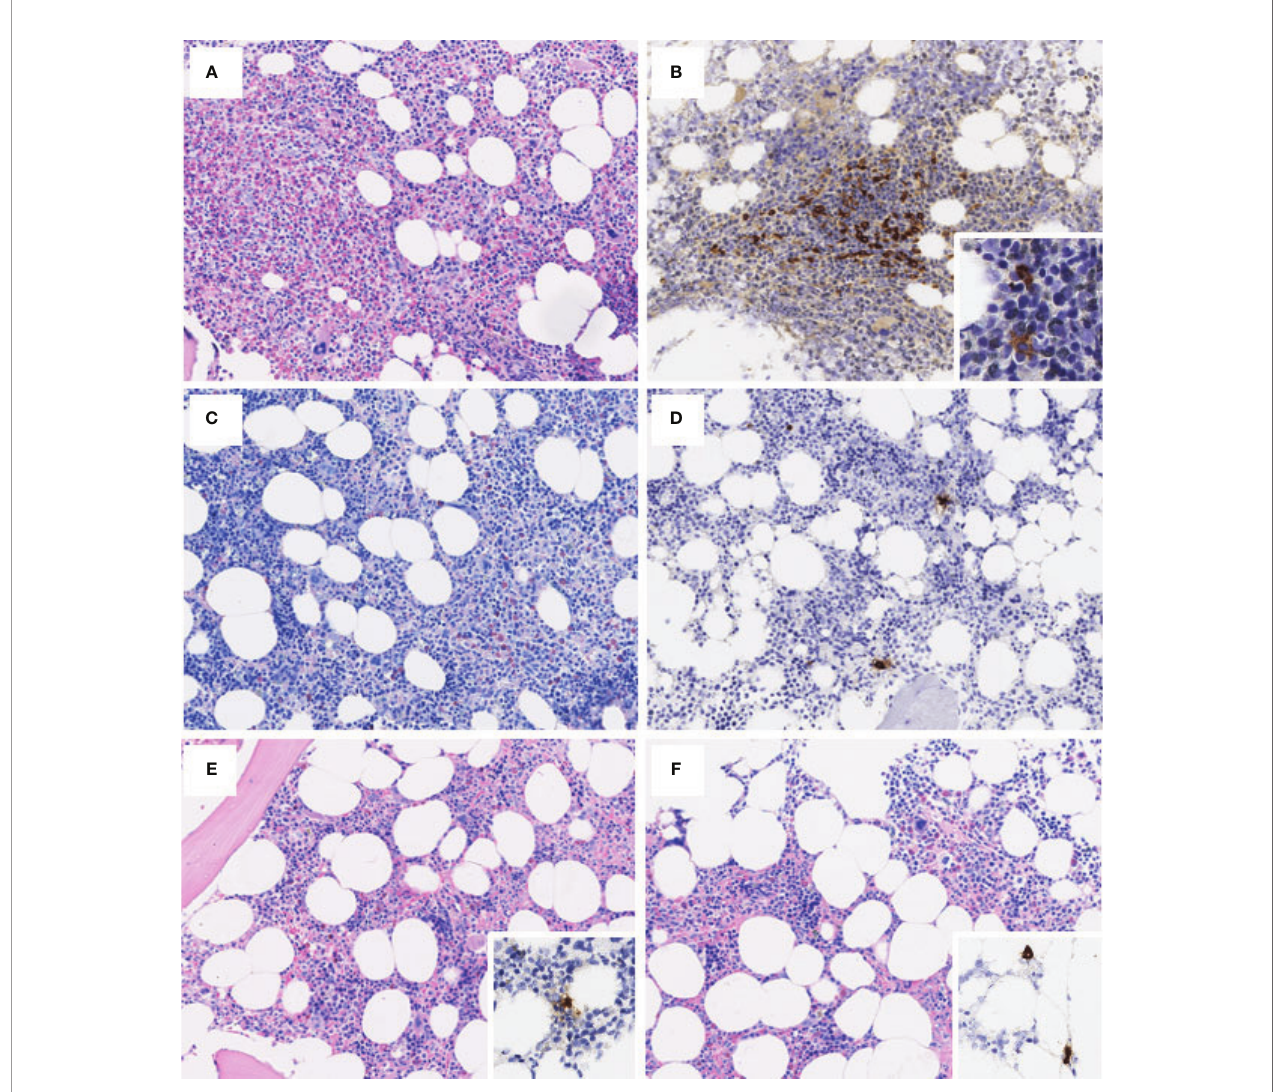
FIGURE 2 | (A) (Giemsa, 200x) depicts a hypercellular bone marrow, featuring expansion of the eosinophilic lineage, comprising maturing to fully mature eosinophils, while tryptase stain [ (B) ; 200x] delineates the presence of scattered aggregates of epitheliod to spindled mast cells, featuring at least partial CD25-positivity (inset, 400x). Bone marrow biopsy at 3 months from Imatinib initiation [ (C) ; Giemsa, 200x] shows a reduction of cellularity, eosinophilic compartment, and mast cells [ (D) ; tryptase, 200x], which appear scattered. Restitutio ad integrum of the hematopoiesis is steadily apparent in subsequent biopsies [ (E, F) ; Giemsa, 200x], with only scattered tryptase+ cells [ (E, F)